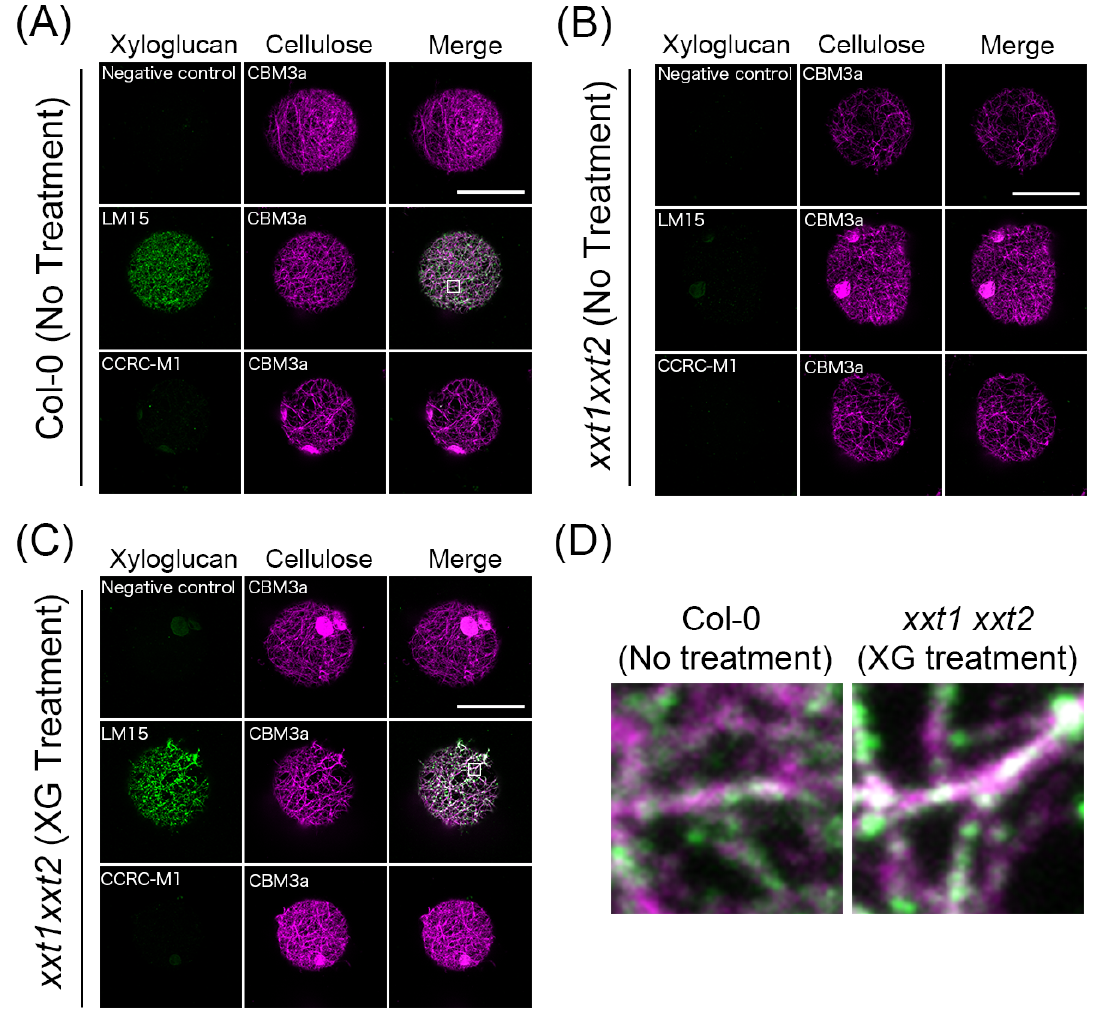
Figure 3. Immunofluorescent labeling of xyloglucan and crystalline cellulose on the surface of Col-0 and xxt1 xxt2 mutant protoplasts. ( A – C ) Immunocytochemistry of protoplasts incubated in the regeneration medium lacking xyloglucan ( A , B ) or containing xyloglucan ( C ) for 24 h. Crystalline cellulose was stained with CBM3a, and xyloglucan was stained with LM15 or CCRC-M1. Distilled water was added instead of LM15 or CCRC-M1 as the negative control. ( D ) Magnified images of the white squares in ( A ) (left) and ( C ) (right). These images show the overlap between LM15 and CBM3a signals. Scale bar = 20 μ m.